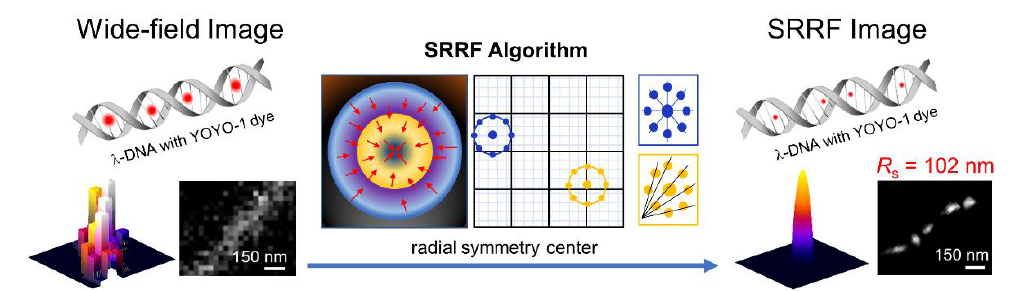
Figure 5. Schematic illustration of single-DNA molecule detection using the TIRF-based SRRF stream module. The image was reproduced with permission from Nguyen et al., published by Wiley-VCH Verlag Gmbh, 2020 [30].